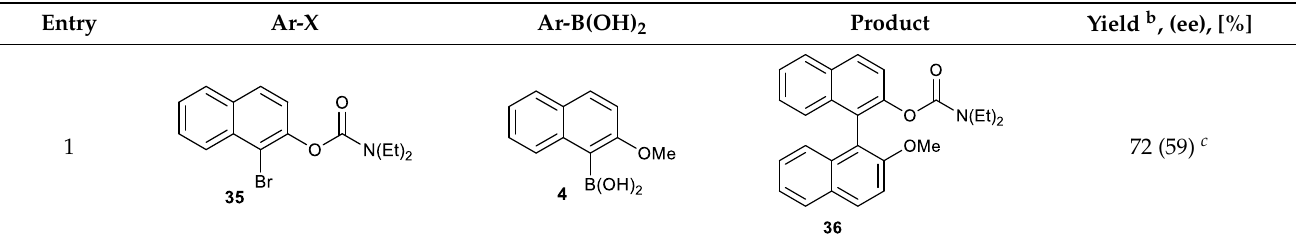
Table 17. Synthesis of biaryls bearing mild-coordinating functional groups a .